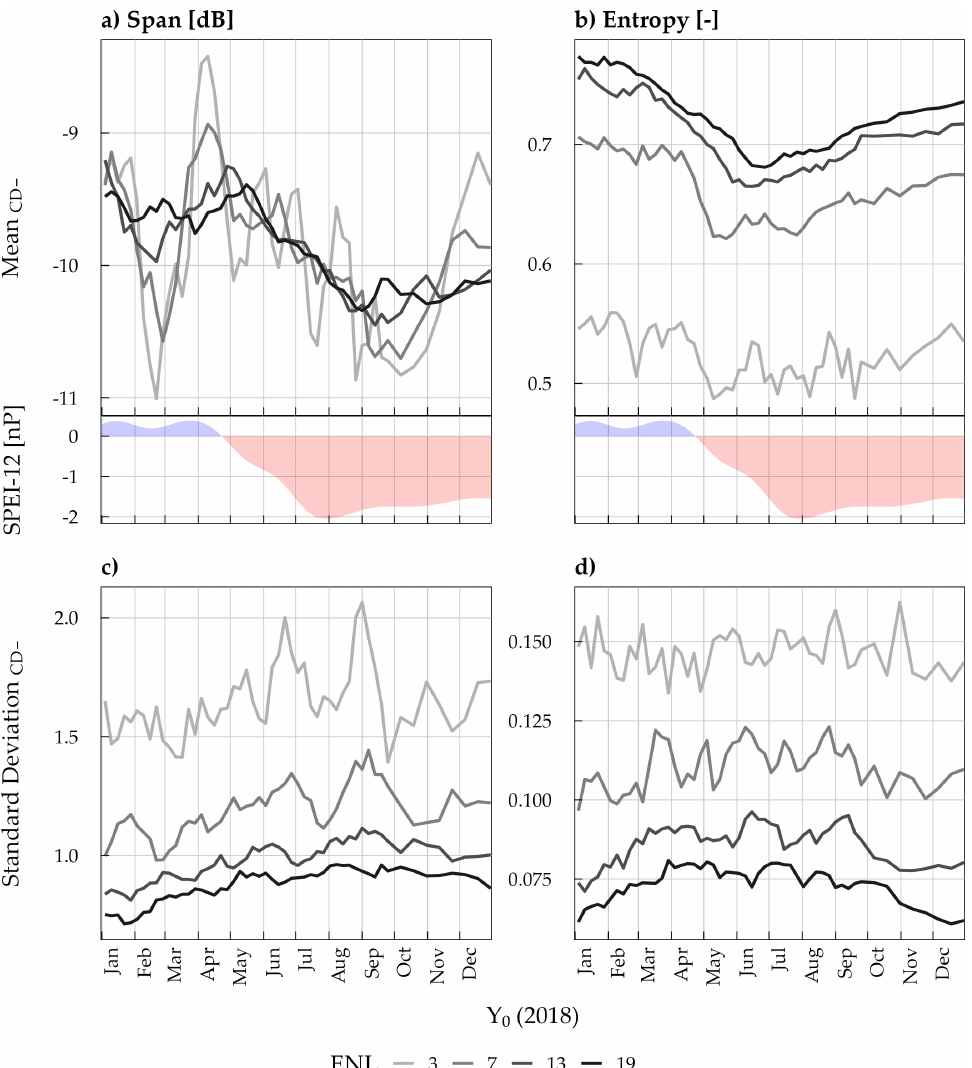
Figure 6. Results of the temporal speckle filters given for the time series mean ( a , b ) and standard deviation (SD, c , d ) exemplarily for the Span backscatter γ 0 ( a , c ) and the eigenparameter entropy Span ( b , d ) for the drought onset year Y 0 using a set of temporal-only rolling mean filters. Besides the mean and standard deviations of the variables, the SPEI relates drought progression to signal